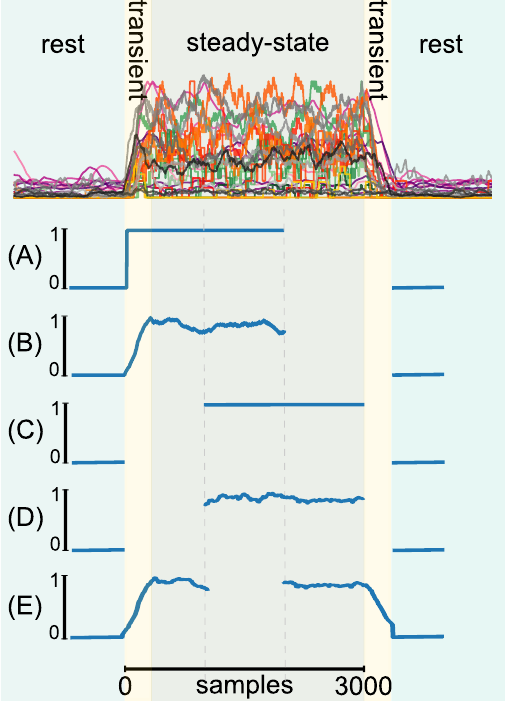
Figure 2. Example for the generated labels. ( A ) Binary label (0 = not active, 1 = active), including the rising transient phase of the EMG signal in the active label. ( B ) Continuous label, including the rising transient phase of the EMG signal in the active label. ( C ) Binary label, using only the steady-state signal (excluding transient phases). ( D ) Continuous label, only using the steady-state part of the signal. ( E ) Continuous label, including the rising and falling transient phases of the EMG